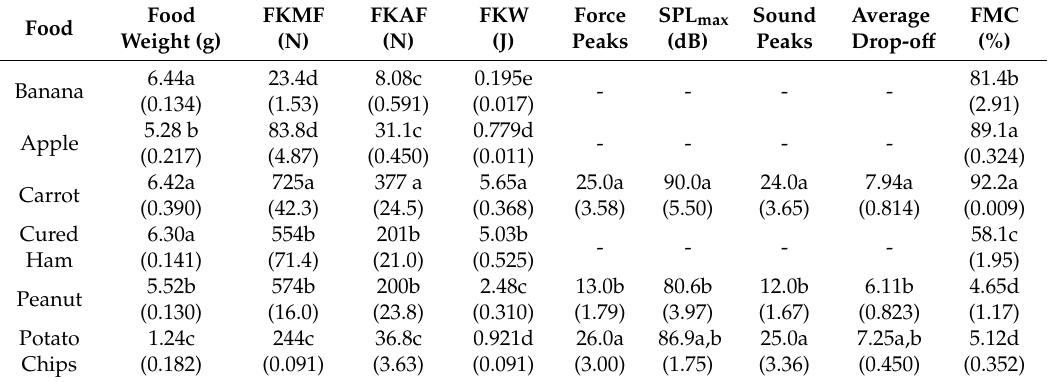
Mean value (standard deviation, SD). Values followed by the same letter within each instrumental parameter indicate no significant differences ( p ≤ 0.05). FKMF: food Kramer maximum force; FKAF: